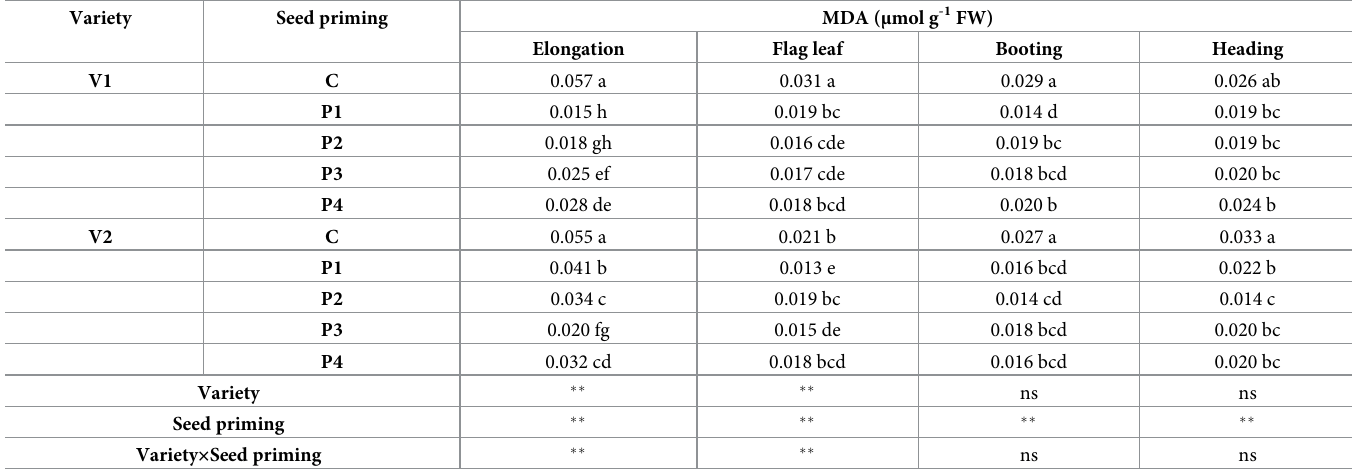
Table 4. Effects of seed priming on MDA of sorghum under salt stress at different growth stages. Variety